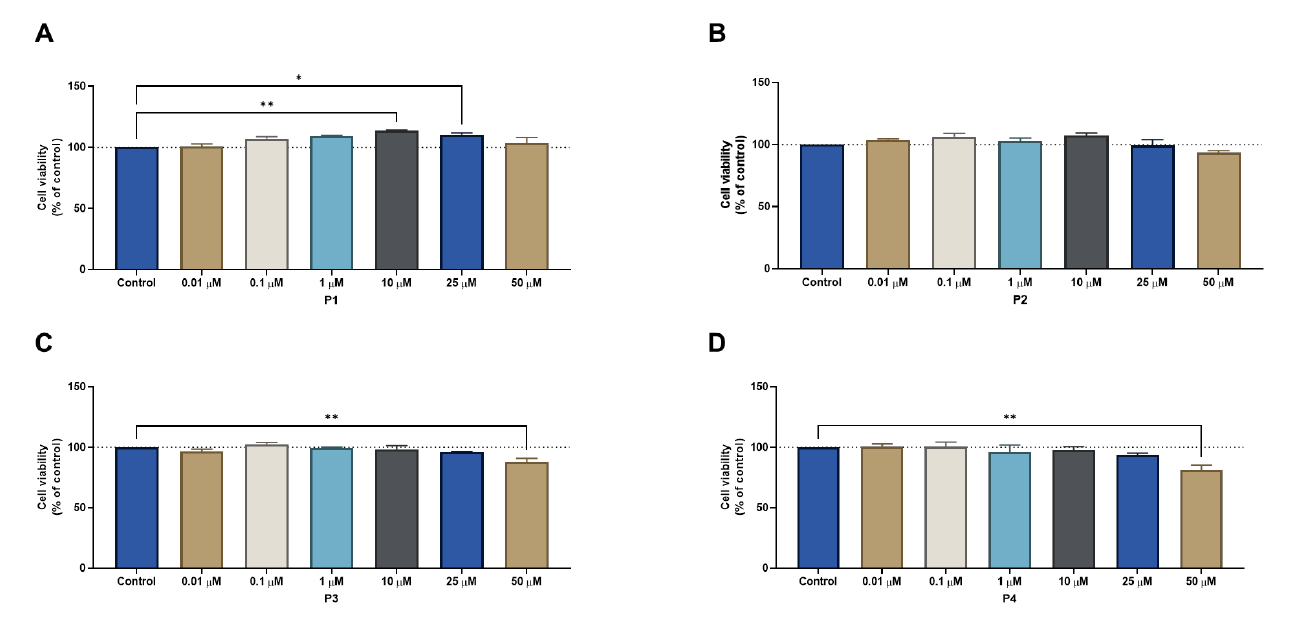
Figure 11. Cytotoxic results of HT-29 after exposure to increasing concentrations of peptides ( A ) P1, ( B ) P2, ( C ) P3, and ( D ) P4 (0.01 – 50 μM) for 48 h. Control cells were treated with 0.01% DMSO (vehicle). Cell viability was obtained using the MTT assay and the results are given as the mean ± SEM ( n = 3). * Statistically significant vs. control (vehicle) at p < 0.05, ** statistically significant vs. drug alone at p < 0.01.